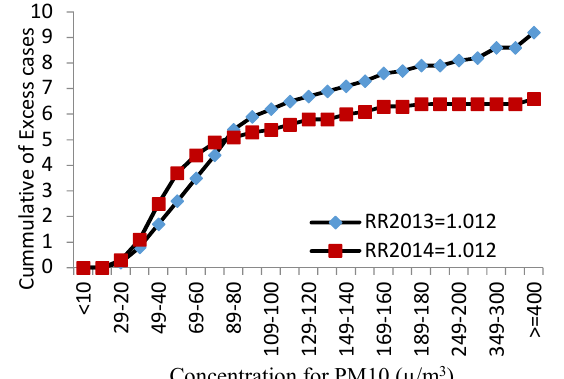
Fig.7. Estimate the total cumulative number of mortality from respiratory diseases related to particles with a diameter less than 10 microns in Ilam using Air Q model in 2013 and 2014